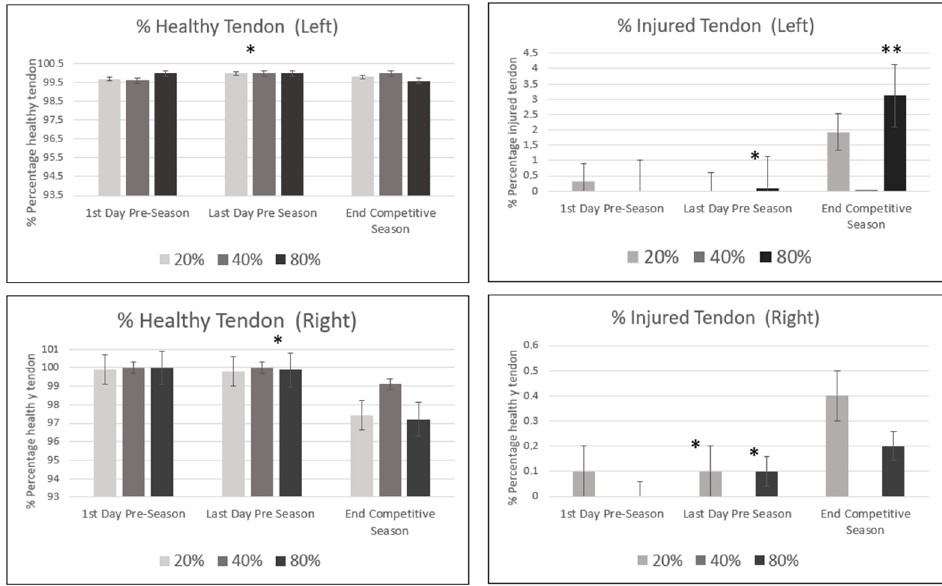
Figure 2. Percentage of healthy and injured tendon (median and Inter quartile Range (IQR) at 20%,